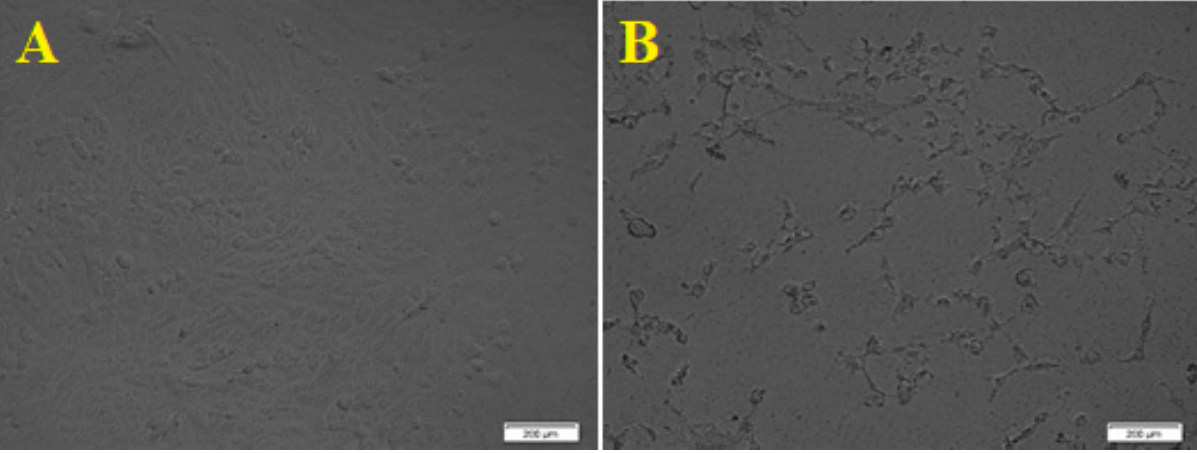
Figure 9. Morphological changes of HepG2 cell line due to the cytotoxicity effect of ZnO NPs. ( A ). Control. ( B ). Morphological changes in the cell after 24 h. Scale bars = 200 μ m.